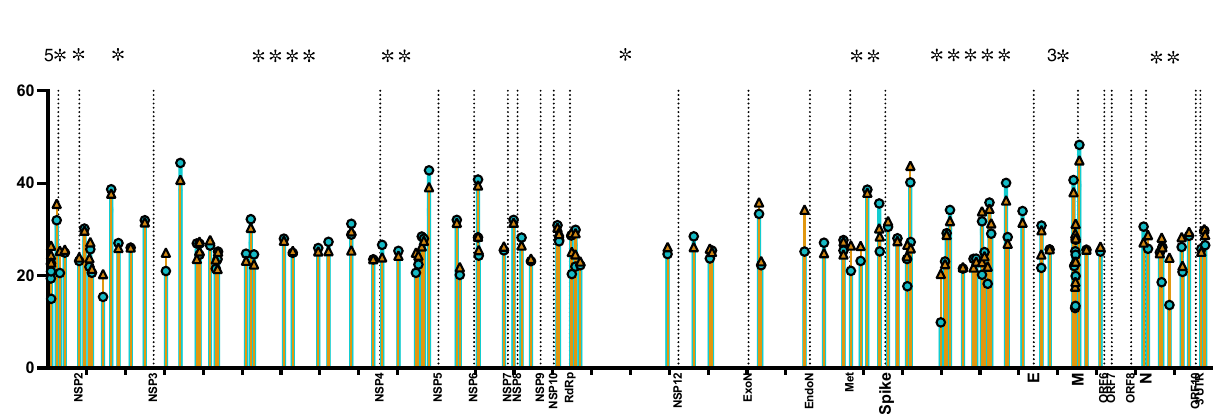
Figure 4. Hotspot position chosen in sample with median of variability for a given position was higher than 25%. One bare represents the mean of variability for one position, blue bars and circle for non-persistent samples, and yellow bars for persistent